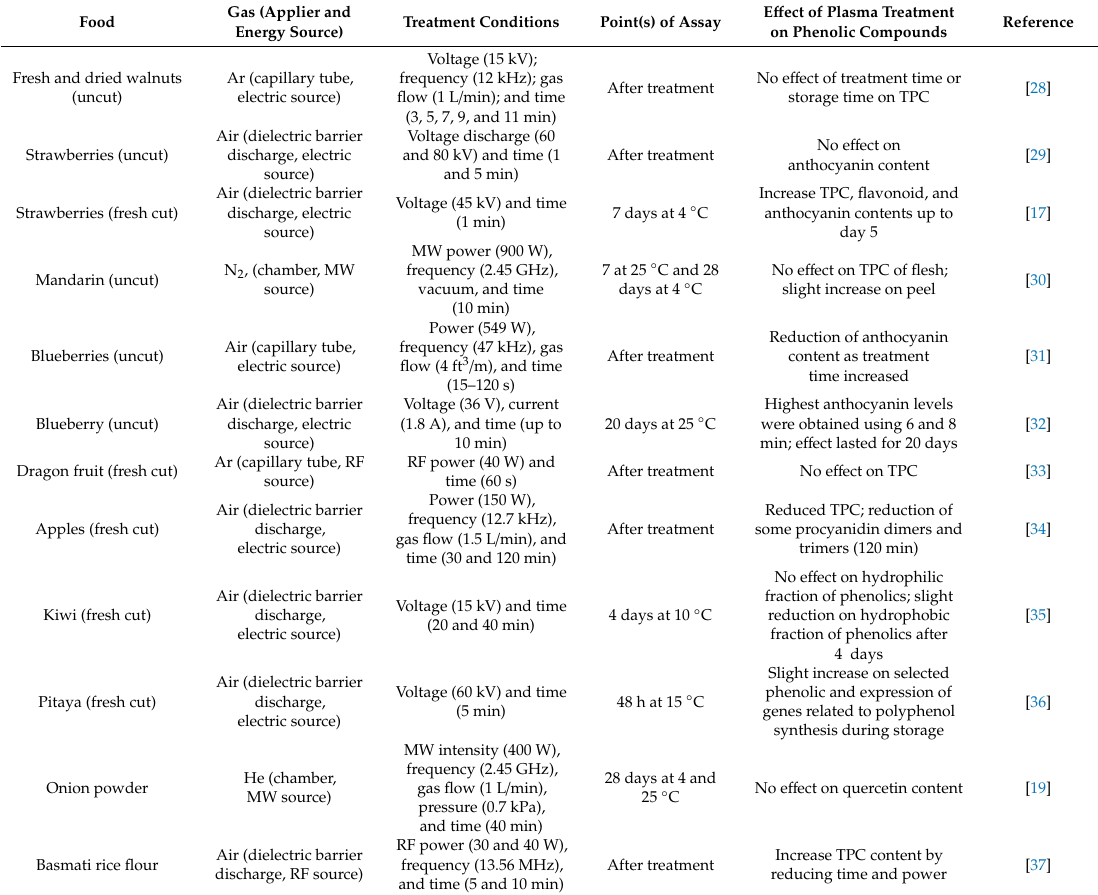
Table 1. Influence of plasma treatments on phenolic compounds of uncut, fresh cut, and processed foods. Food Gas (Applier and Energy Source) Treatment Conditions Point(s) of Assay E